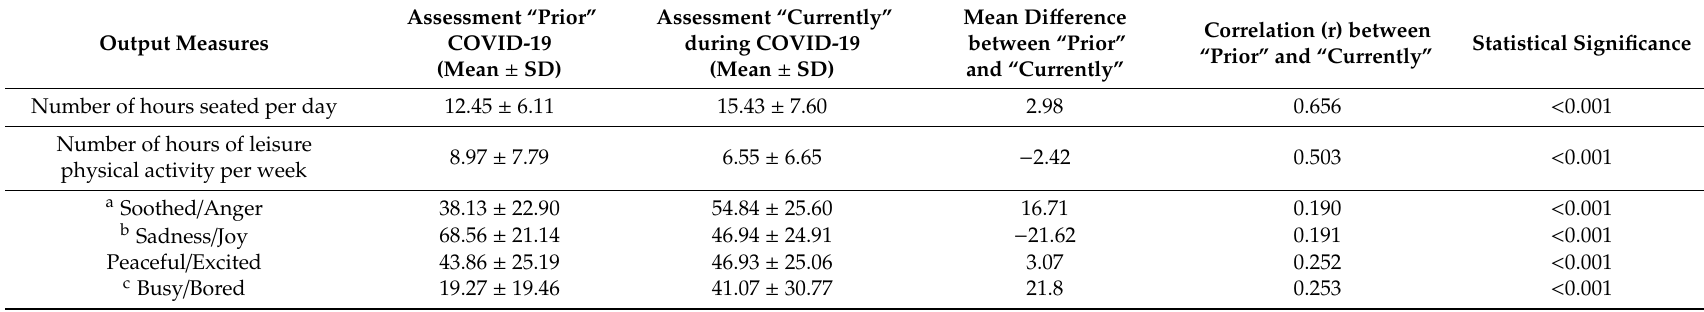
Table 1. Descriptive statistics showing the “Prior” and “Currently” dataset summary of the VAS intensity scale for the three components / output measures. Output